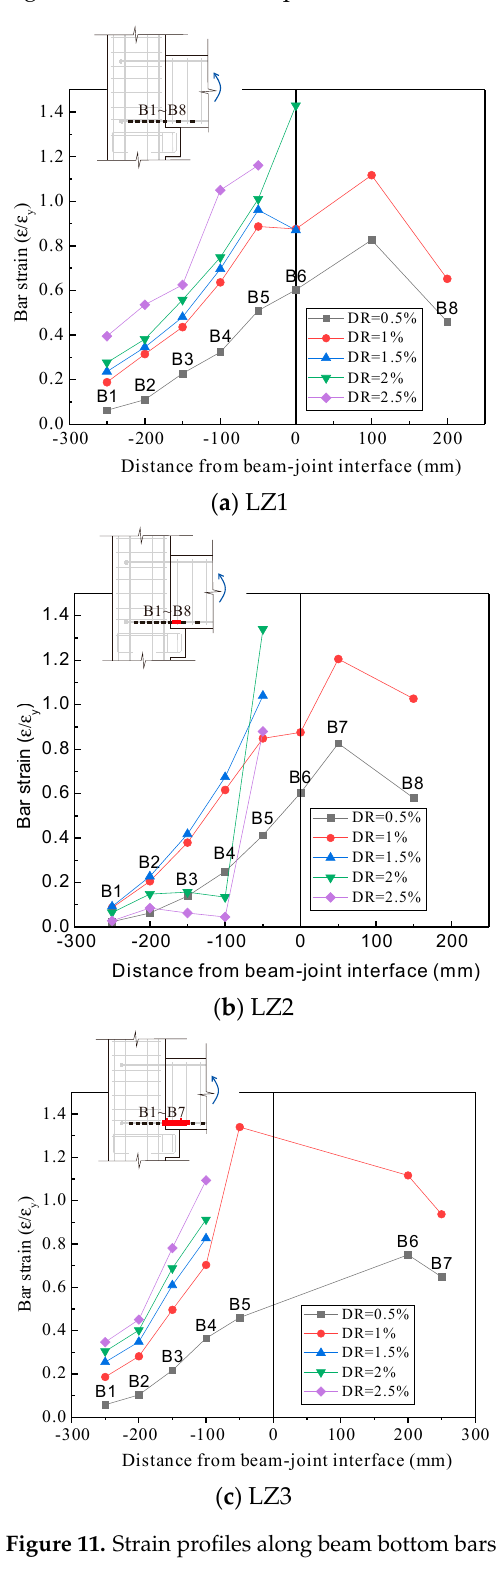
Figure 11. Strain profiles along beam bottom bars.